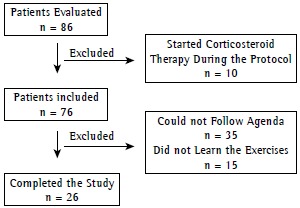
Flowchart of the study.